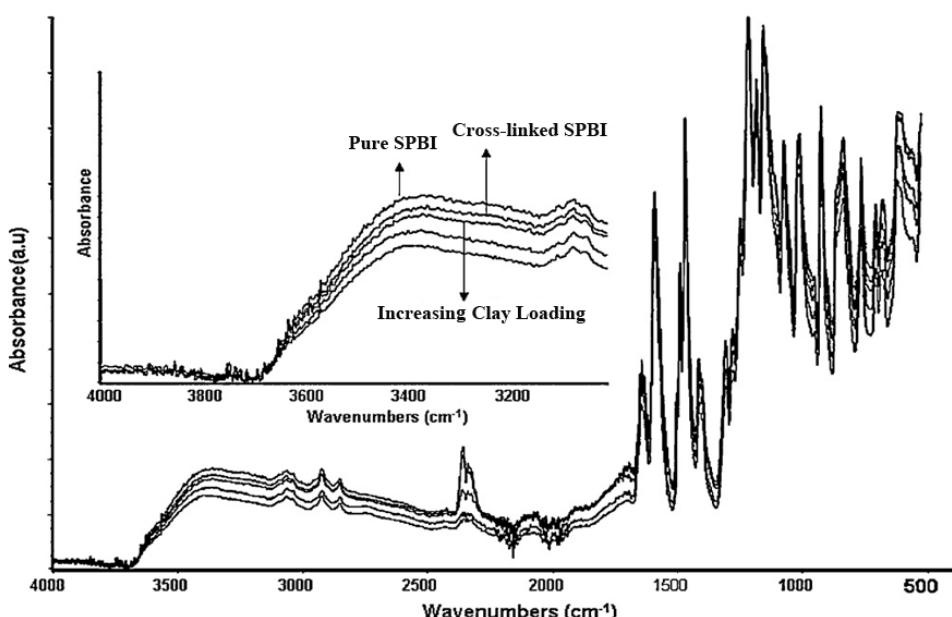
Fig. 3. Normalized FTIR spectra of pristine SPBI, neat cross-linked SPBI and cross-linked SPBI/clay nanocomposite membranes. The magnified OH stretching region is given in the inset